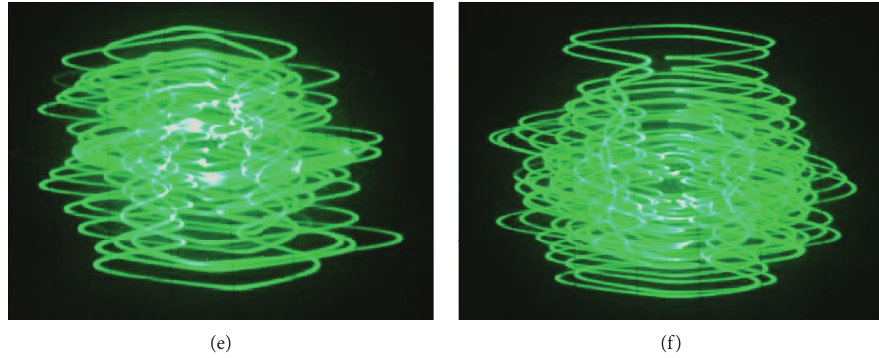
Figure 13: Experiment observations of the proposed 5D memristive hyperchaotic system: (a) X - Z plane, (b) Y - Z plane, (c) X - Y plane, (d) X - W plane, (e) Y - W plane, (f) Y - U